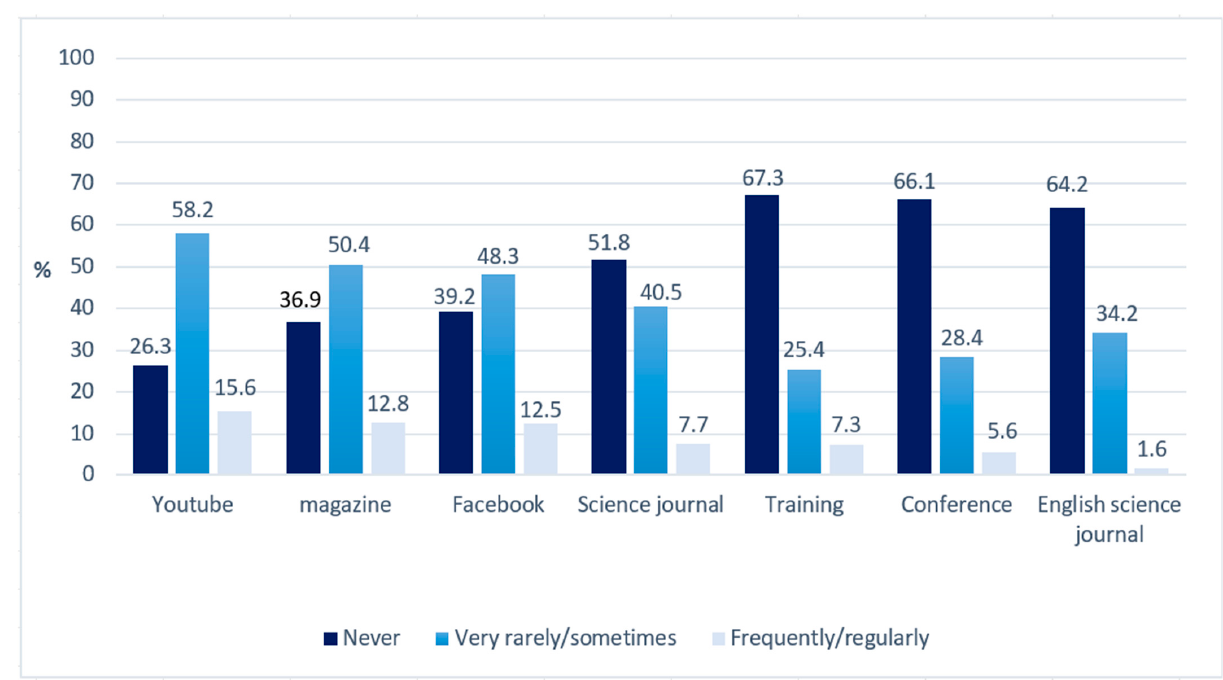
Figure 1. Frequency (%) of using various sources of information about neuroscience.